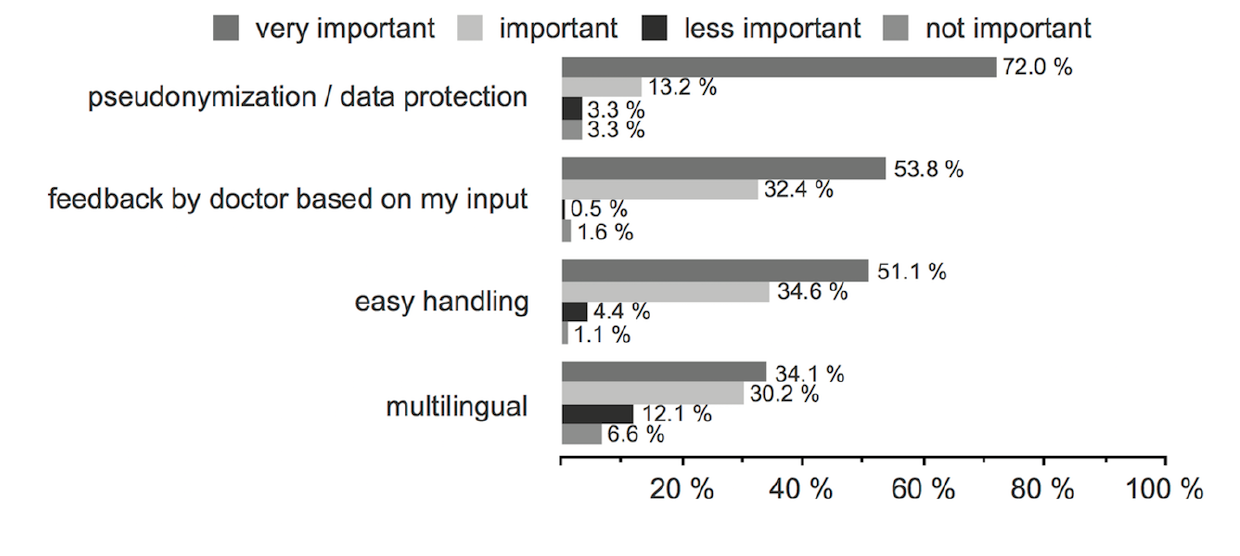
Figure 4. Q21: Figure listing desired additional functions